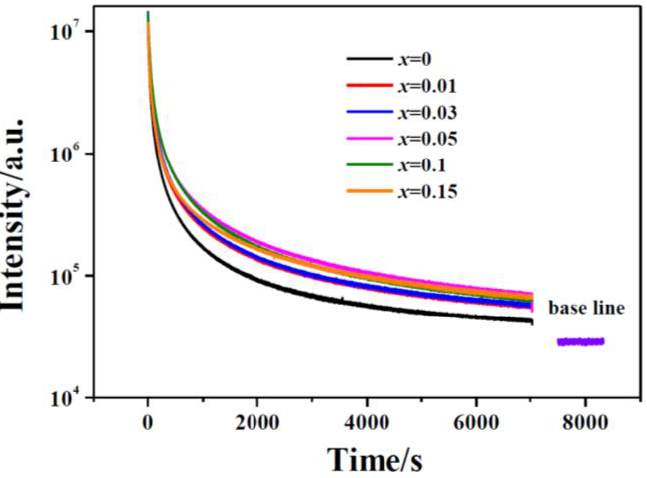
Figure 8. Schematic illustration of energy level diagram.